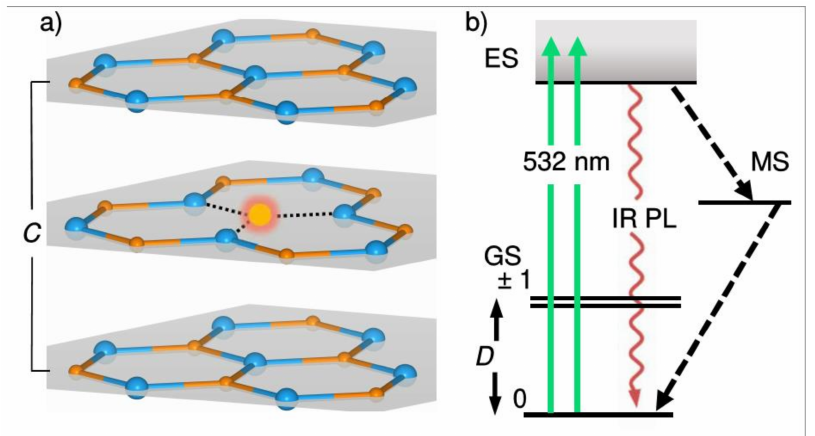
Figure 1. ( a ) Schematic representation of the hBN lattice. Boron vacancy is shown as the glowing spot. Nitrogen and boron are shown in blue and brown colors, respectively. The basal 2D planes (grey) of sp 2 -hybridized Nitrogen–Boron atoms are stacked perpendicular to the hexagonal c -axis. ( b ) V − center energy levels diagram in the absence of external static magnetic field and the scheme of B optical pumping cycle of the ground state (GS) m s = 0 spin sublevel. Excitation (green) transfers the system into the excited state (ES). Radiative recombination (purple) and spin-dependent nonradiative intersystem crossings decay to the GS via metastable state (MS) (dashed lines). D denotes the